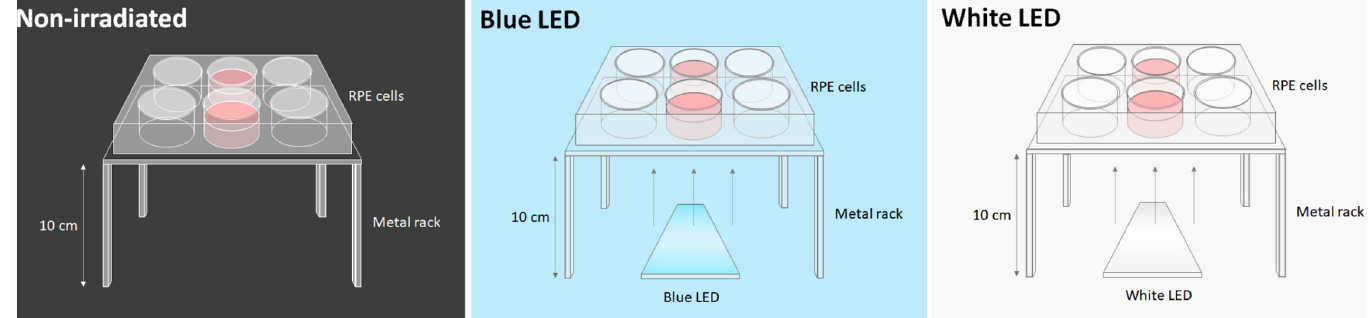
Fig 1. A schematic diagram of the experimental setup in the culture incubator. RPE cells were exposed to 1700 lux of blue (peak λ at 448 nm and 523 nm; 0.85 mW/ cm 2 ) or white (peak λ at 443 nm and 533 nm; 0.44 mW/cm 2 ) LED light for 16 h inside the incubator. Cells were cultured in darkness as a negative control. The culture plates were placed on a metal rack, while the selective blue-filtering (S-BF) and UV-filtering (UVF) lenses were placed beneath the culture plates respectively.